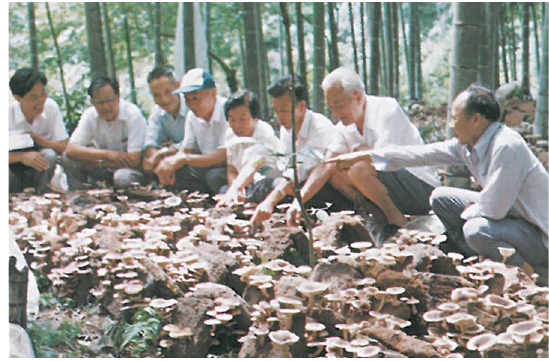
Figure 7. Dr. Fan at a mushroom fruiting